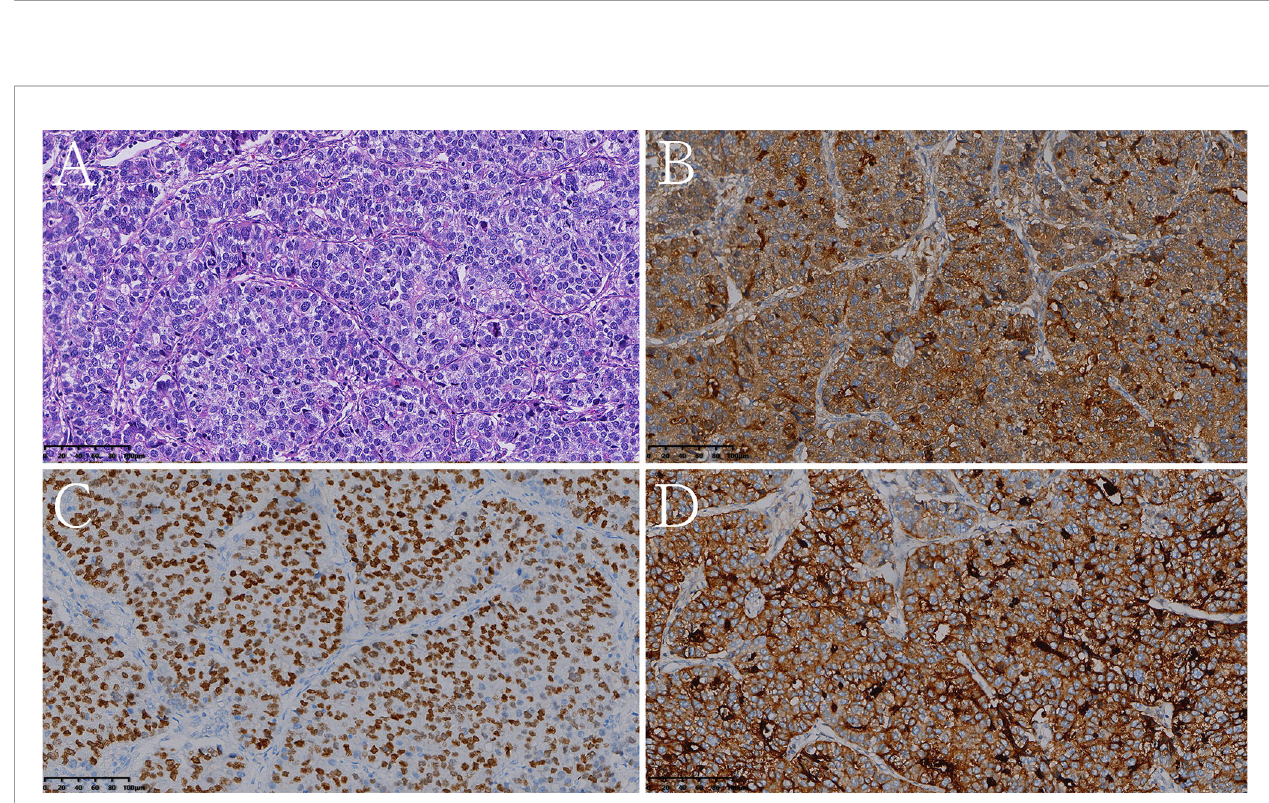
FIGURE 6 | Histologic and immunohistochemical features of pure hepatoid adenocarcinoma of the stomach (pHAS). (A) Hematoxylin and eosin (HE) staining. On immunohistochemistry, the tumor cells were positive for AFP (B) , SALL4 (C) , glypican 3 (D) (magni fi cation (A – D) ×200).